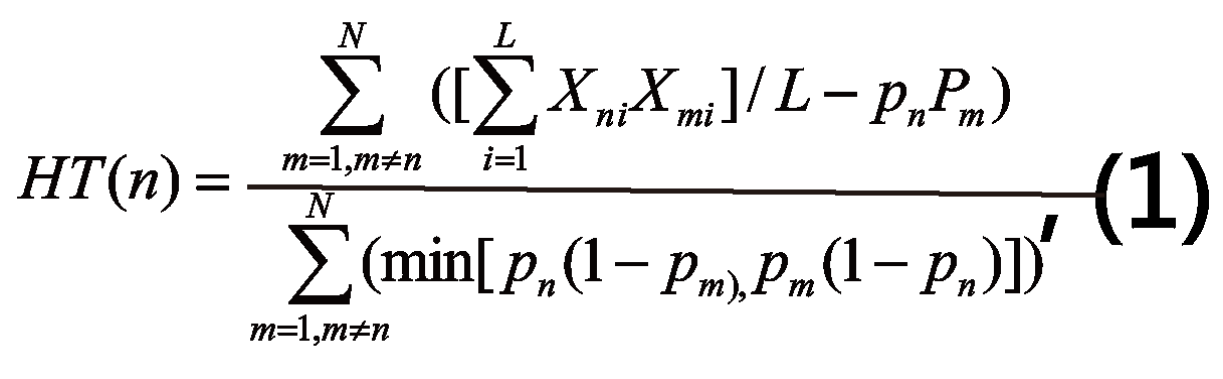
Figure 1. The equation of the HT fit statistic.